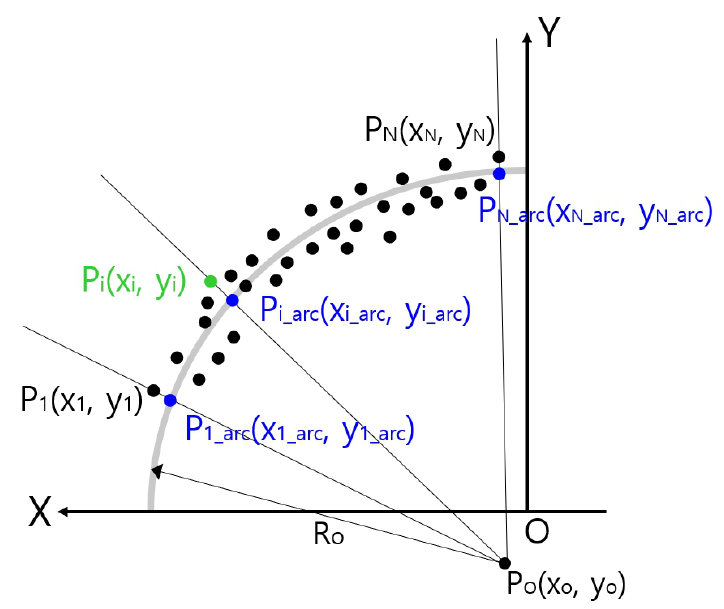
Figure A1. Variables for geometric piecewise arc curve